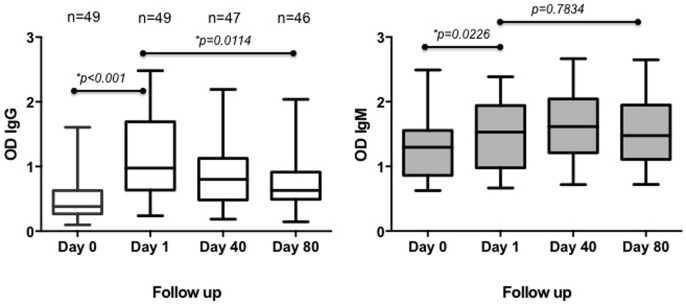
Follow-up study: Concentration of IgG and IgM antibodies of healthy individuals residing in Pamplona during the follow up.Representation in optical densities (OD) of the concentration of IgG antibodies against Ae. aegypti mosquito SGE. Statistical significance of Wilcoxon matched-pairs signed rank test represented as (*) p<0.05.